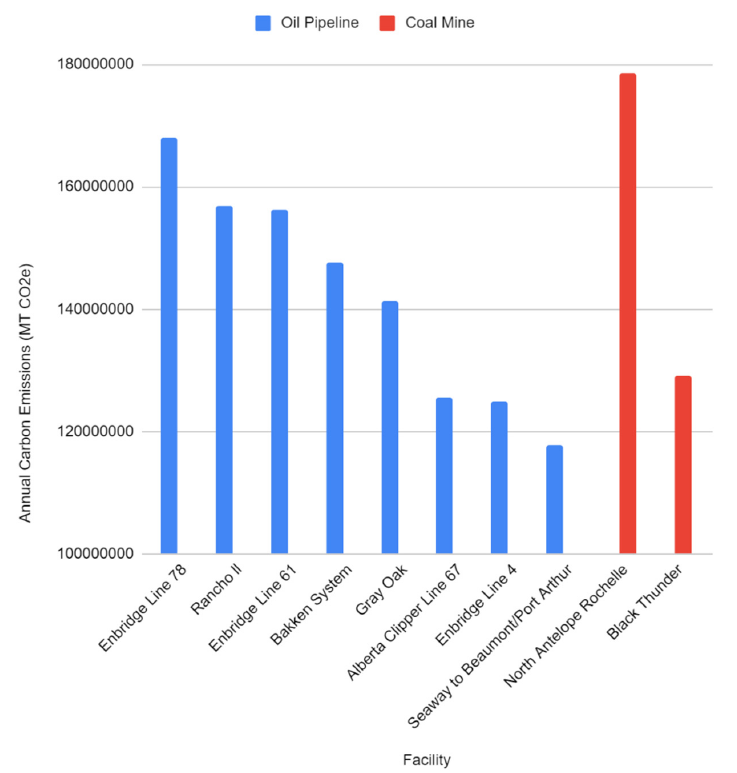
Figure 9. Overall Top 10 CO 2 Emission Point-Sources Across All Fossil-Fuel Industries in U.S.